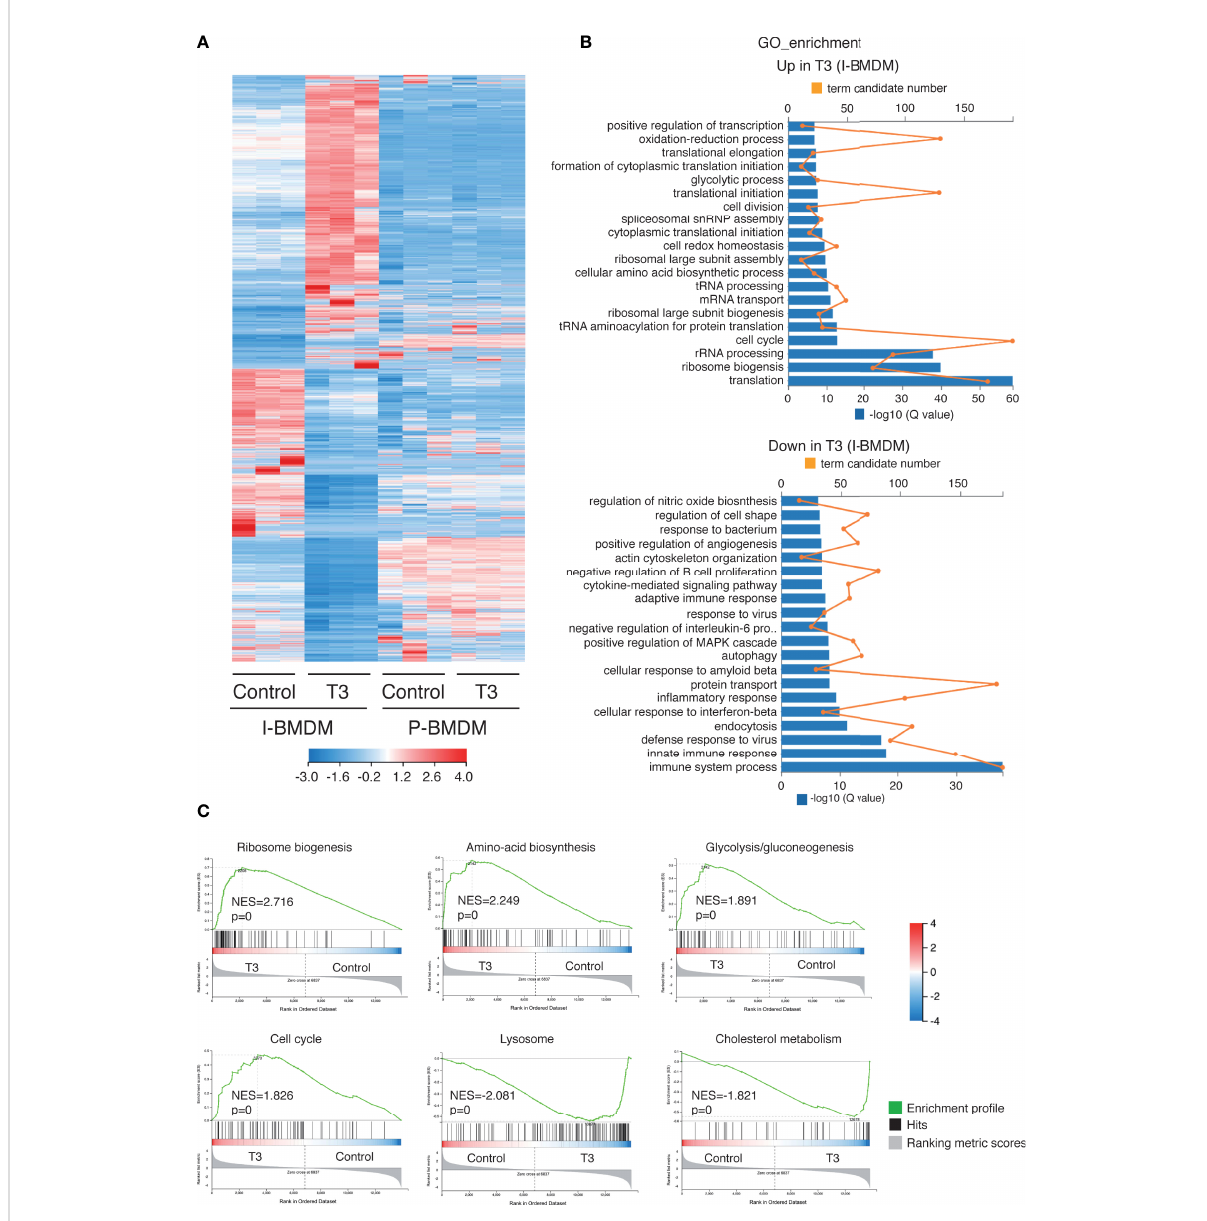
FIGURE 6 T3 induces expression of genes involved in cell proliferation and protein translation in immortalized macrophages. (A) Heatmap showing differential expression of transcripts between immortalized (I-BMDM) and primary (P-BDMD) cells. P-BMDM, differentiated in complete medium supplemented with M-CSF, were shifted to thyroid hormone depleted medium and cultured in absence (control) and presence of 10 nM T3 for 2 days. I-BMDM were treated under the same conditions. (B) Top overrepresented gene ontology (GO) categories with signi fi cant transcripts enrichment (upper panel) or reduction (lower panel) in the T3-treated I-BMBM with respect to the untreated cells. Both the term candidate transcript number (in orange) and the Q value (in blue bars) are depicted in the plots. (C) Enrichment plots from Gene Set Enrichment analysis (GSEA) based in KEEG pathway database showing the top over-represented hallmarks in up-regulated and down-regulated genes in T3-treated I-BMDM. The normalized enrichment scores (NES) as well as the nominal p values are